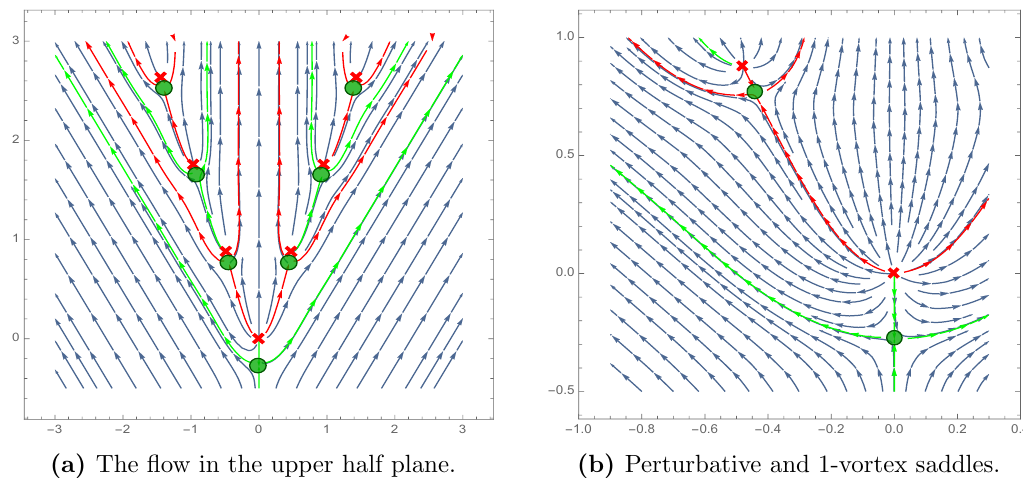
(a) The (cid:13)ow in the upper half plane. (b) Perturbative and 1-vortex saddles. Figure 3. Morse (cid:13)ow for the theory with one chiral and one anti-chiral, b = e i= 2 , (cid:24) = 1. The green circles are saddles and the red crosses are poles. From each saddle the downward (cid:13)ows (the J cycles) go o(cid:11) to the sides and eventually o(cid:11) to 1 . The upward (cid:13)ows (K cycles) (cid:13)ow up or down to the nearest pole. Only the K cycle from the perturbative saddle hits the real axis.